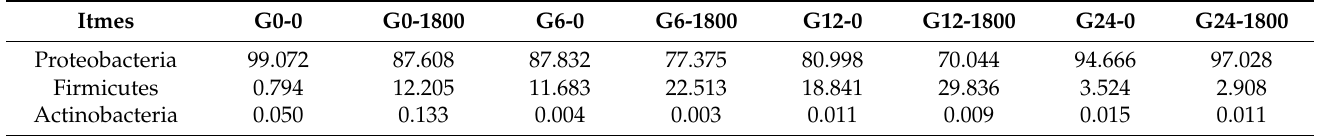
Table 3. Relative abundance values at the phylum level for all